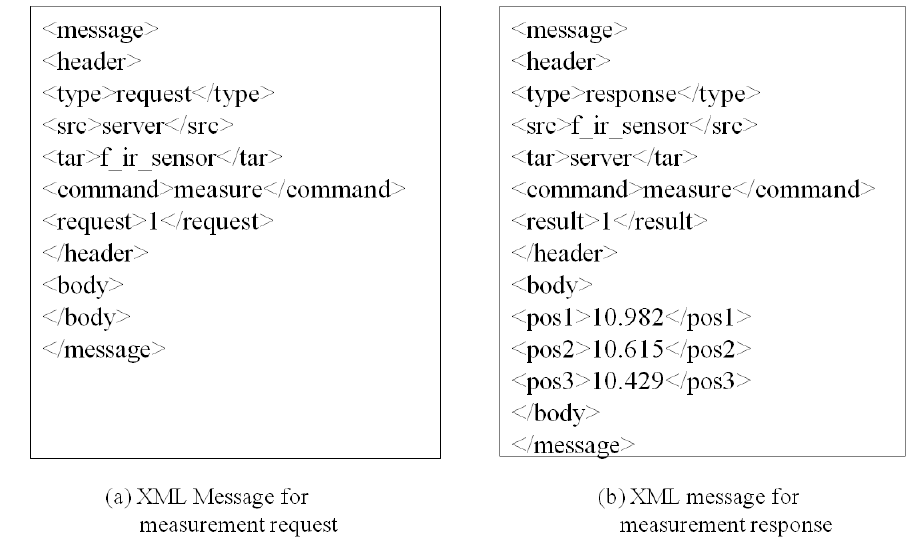
Figure 14. XML message examples for data transmission.